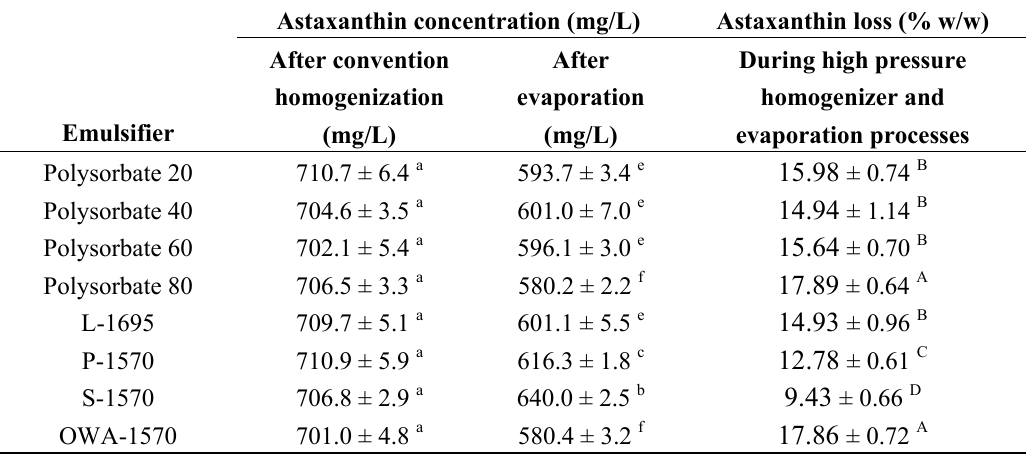
Table 3. Astaxanthin concentration of nanodispersions during preparation